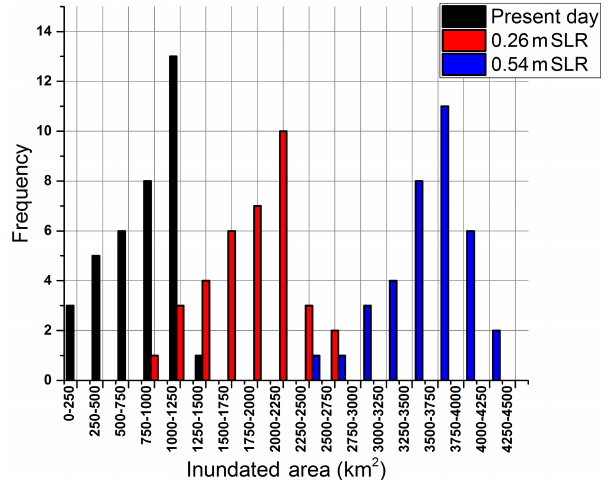
Figure 6. Ensemble projection of the future SLR impact on storm surge inundation. The column in black represents the inundation events for the present-day sea level condition, the red one is for 0.26m of SLR and the blue column is for 0.54m of SLR conditions. In total 108 simulations were conducted for one present and two future SLR scenarios.